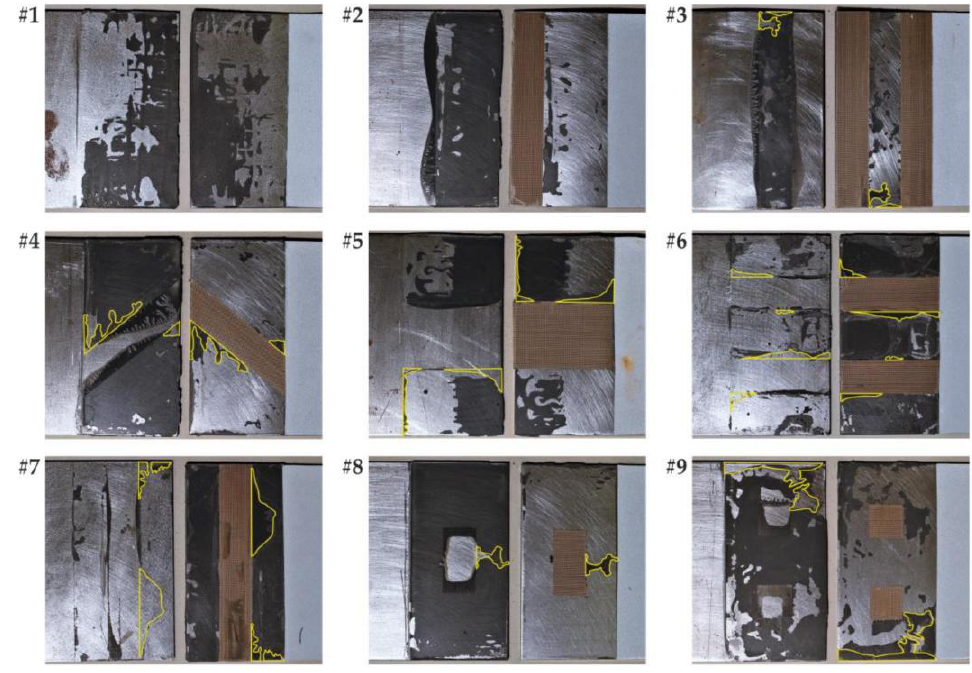
Figure 3. Photographs of the investigated specimens after separation (regions outlined with yellow line denote kissing defects).